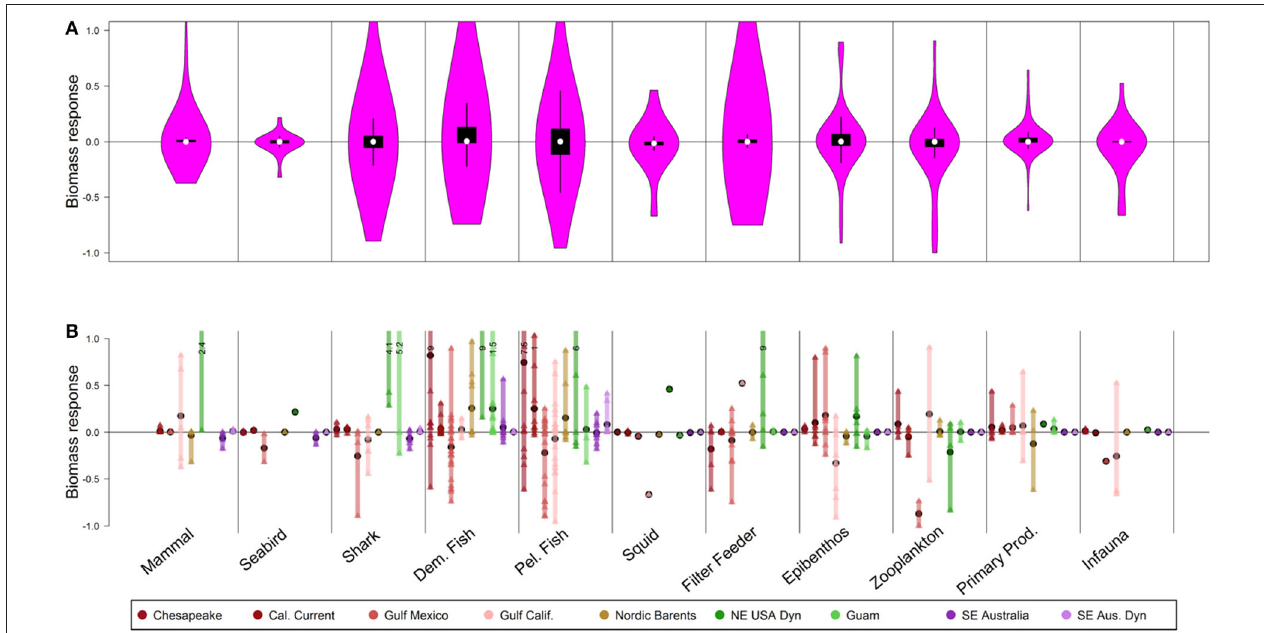
FIGURE 3 | As in Figure 2 , but representing biomass response of 50-year scenarios of spatial management closing 50% of continental shelf ( < 250m depth) to fishing. Note that the proportion of the model domain closed varies depending upon depth of the system (see Table S1).